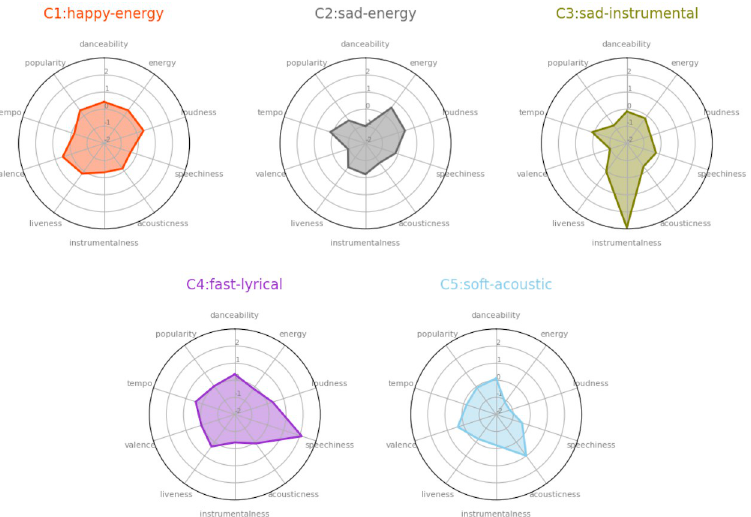
Fig 2. Subgroups of dance music. Five clusters of dance songs ( N = 278) are illustrated with individual Spotify audio feature variation. Clusters were named as “happy-energy” ( N = 101), “sad-energy” ( N = 60), “sad-instrumental” ( N = 23), “fast lyrical” ( N = 35) and “soft-acoustic” ( N = 59) according to their most distinctive audio features. Please note that all of the features are